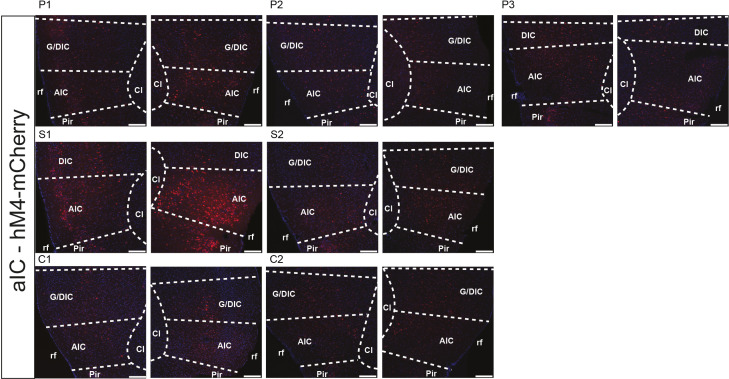
Histology of hM4 expression in calcium imaging cohorts.Injection site of AAV-DIO-hM4-mCherry and AAV::Cre into aIC. Scalebar = 200 µm. AIC – agranular insula, Cl – claustrum, G/DIC – granular/dysgranular insula, Pir – piriform cortex, rf – rhinal fissure.